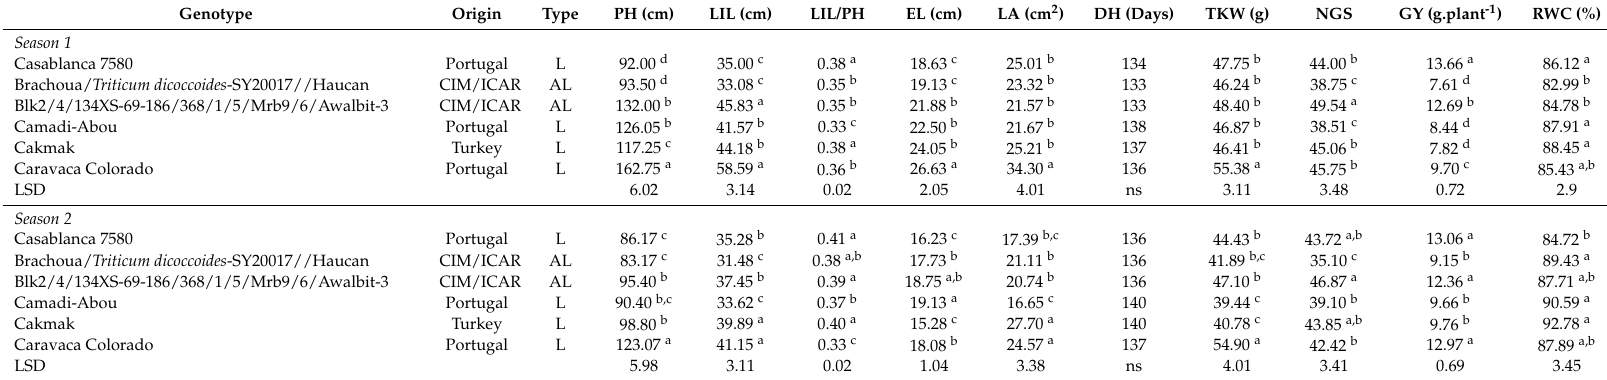
Table 1. The main morphological, physiological, agronomic characteristics and precocity of the six genotypes studied (LSD: least significant difference).